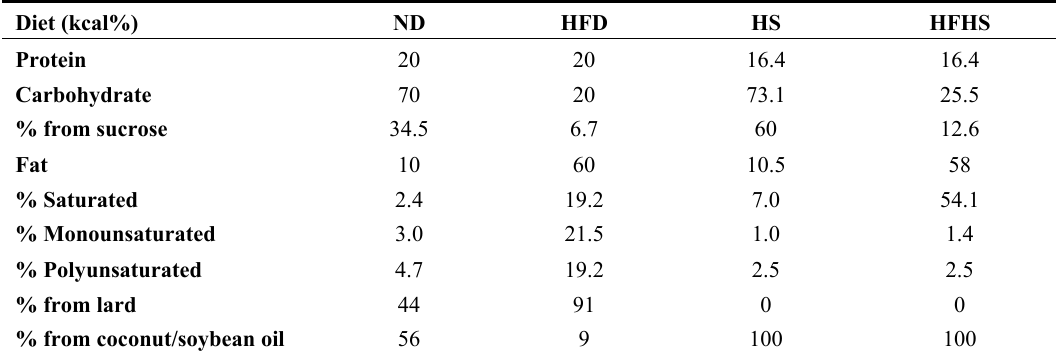
Table 1. Dietary composition of the experimental